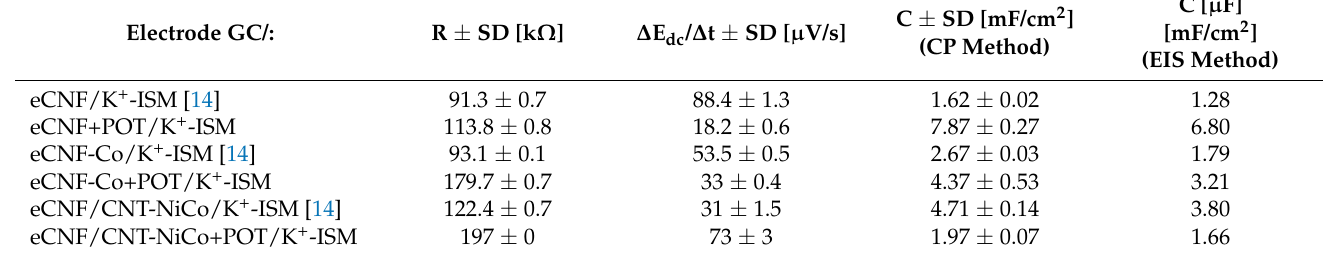
Table 2. Electrical parameters of the investigated K + -ISE.